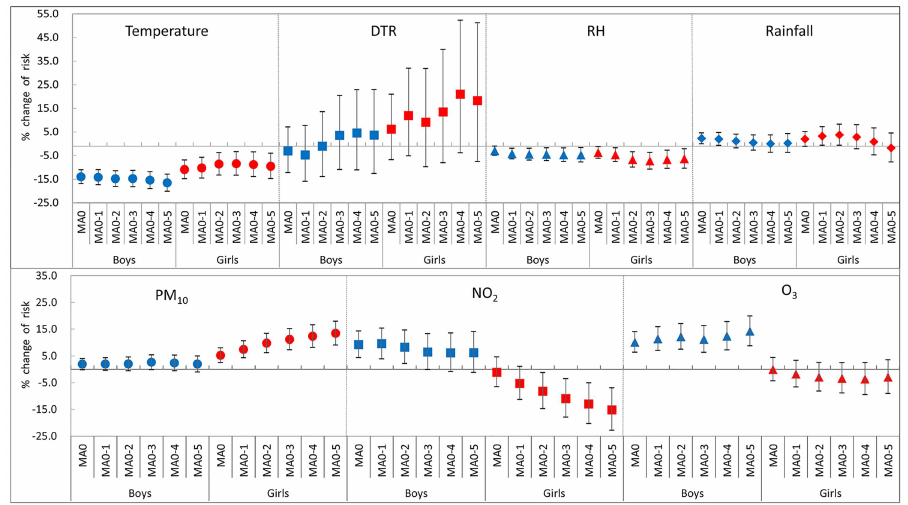
Fig 3. Effects of meteorological variables and air pollution on Atopic Dermatitis(AD) symptoms in boys (A) and girls (B). Data represent percent changesand 95% confidenceintervals in AD symptoms per 5-unit increasein daily mean temperature(˚C), relativehumidity (%), diurnal temperature range (˚C), and rainfall(mm) and 10-unit increase in PM 10 ( μ g/m 3 ), NO 2 (ppb), and O 3 (ppb). DTR: diurnaltemperature range; RH: relative humidity; MA: moving